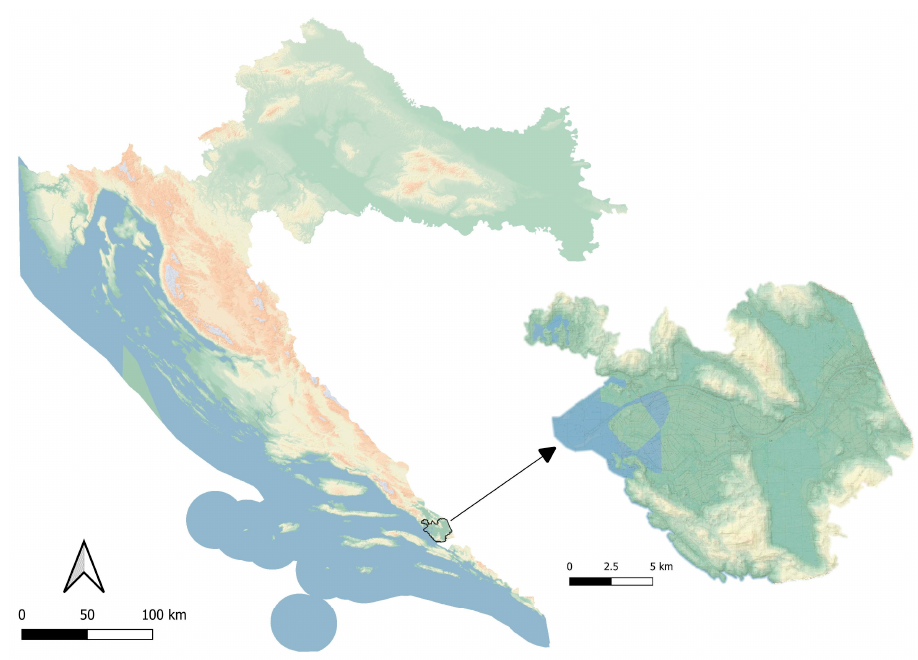
Figure 1. Location of river Neretva delta in the regional and national context.